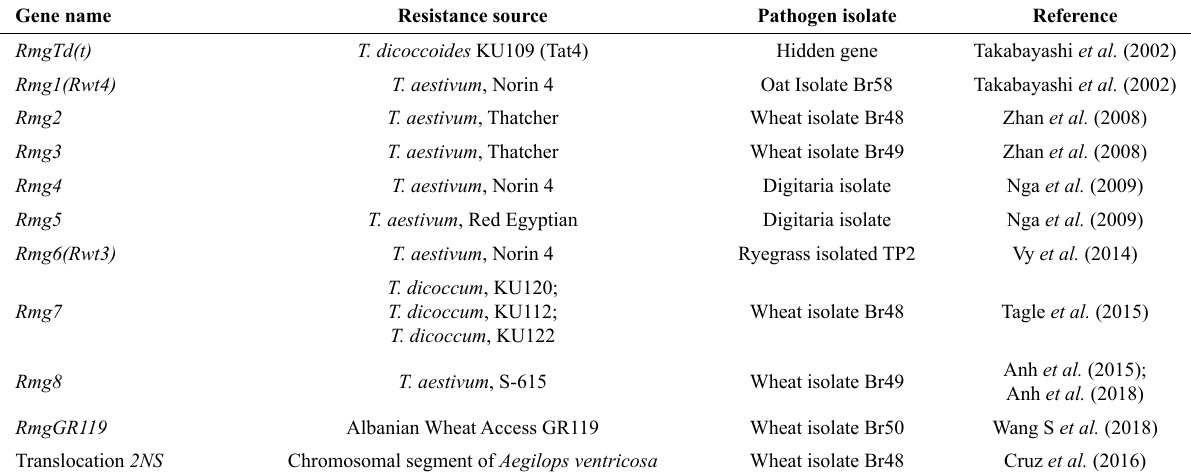
Table 1 - Sources of resistance to wheat